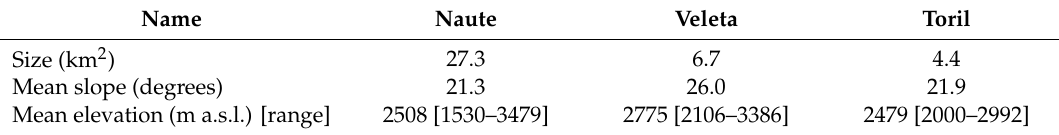
Figure 1. Location of the Poqueira River basin in southern Spain and the three RoR plants system in the pilot area. The sub-basin where seasonal forecast data are produced and the sub-basins defining three different points of water uptake for the hydropower production (SHYMAT sub-basins) are also presented. Table 1. Size, mean slope, and mean elevation of the three catchments of interest in the pilot system.